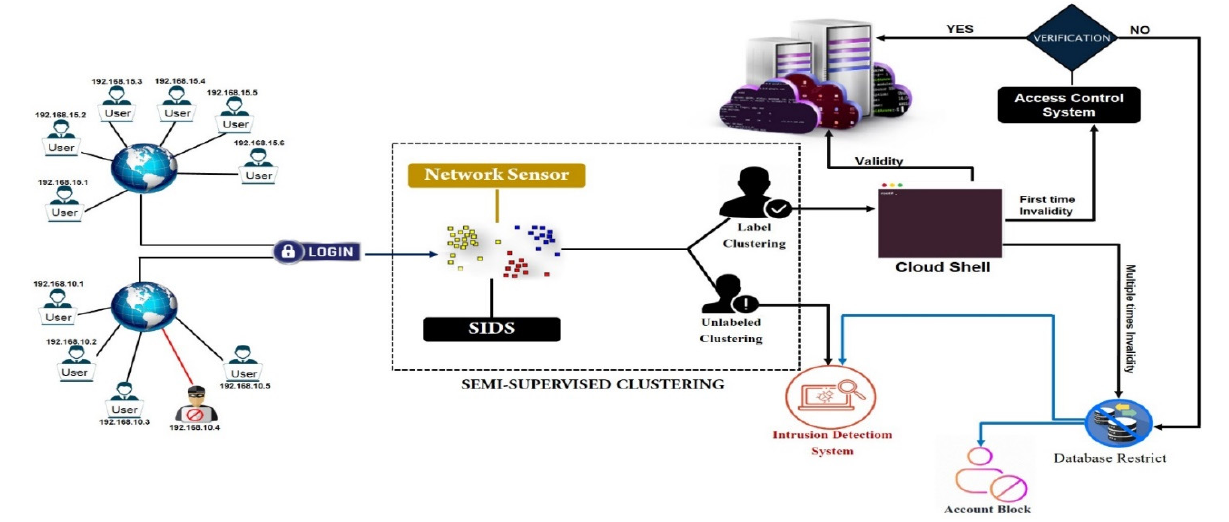
Figure 2. The architecture of Cloud Computing .